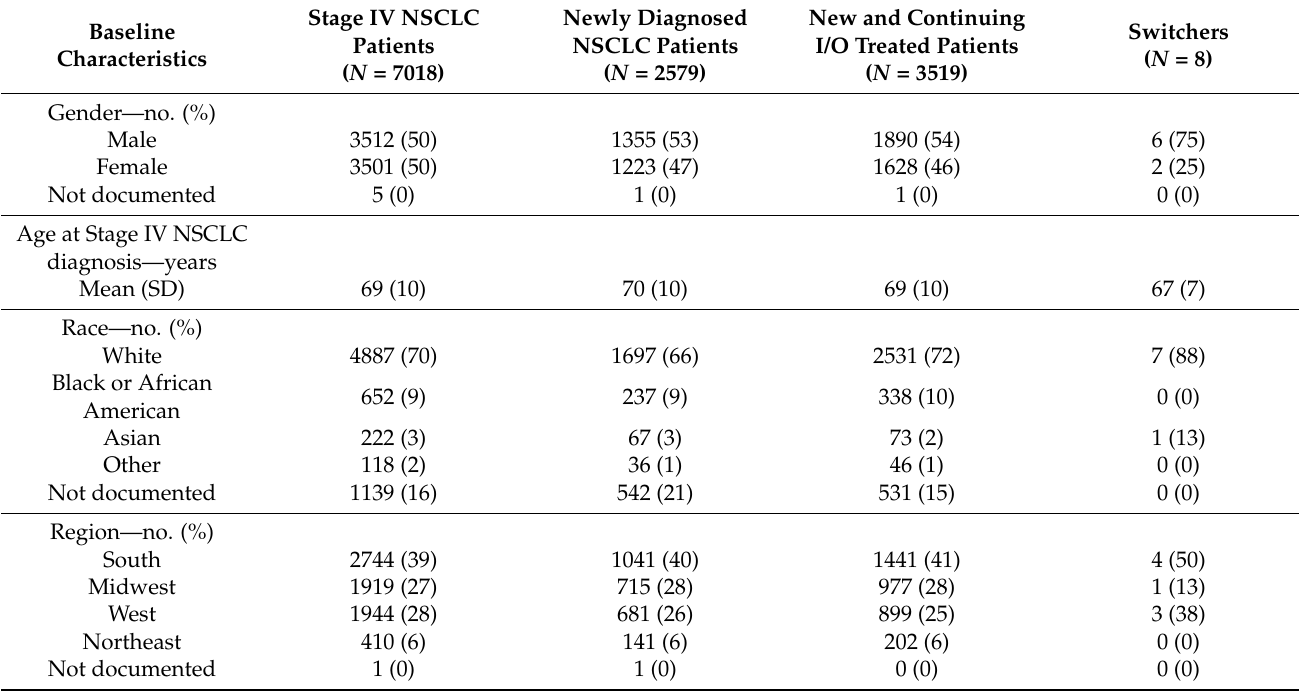
Table 1. Baseline